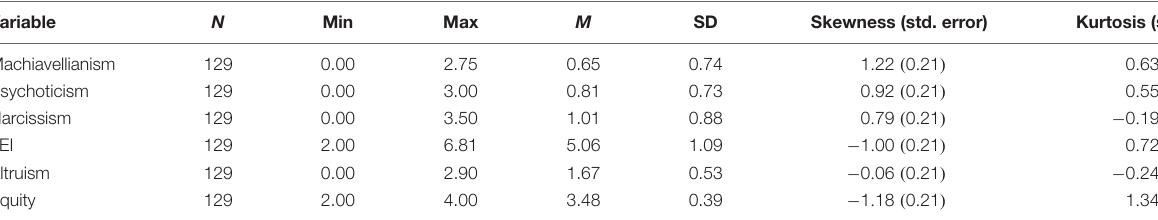
TABLE 1 | Descriptive statistics for study variables.